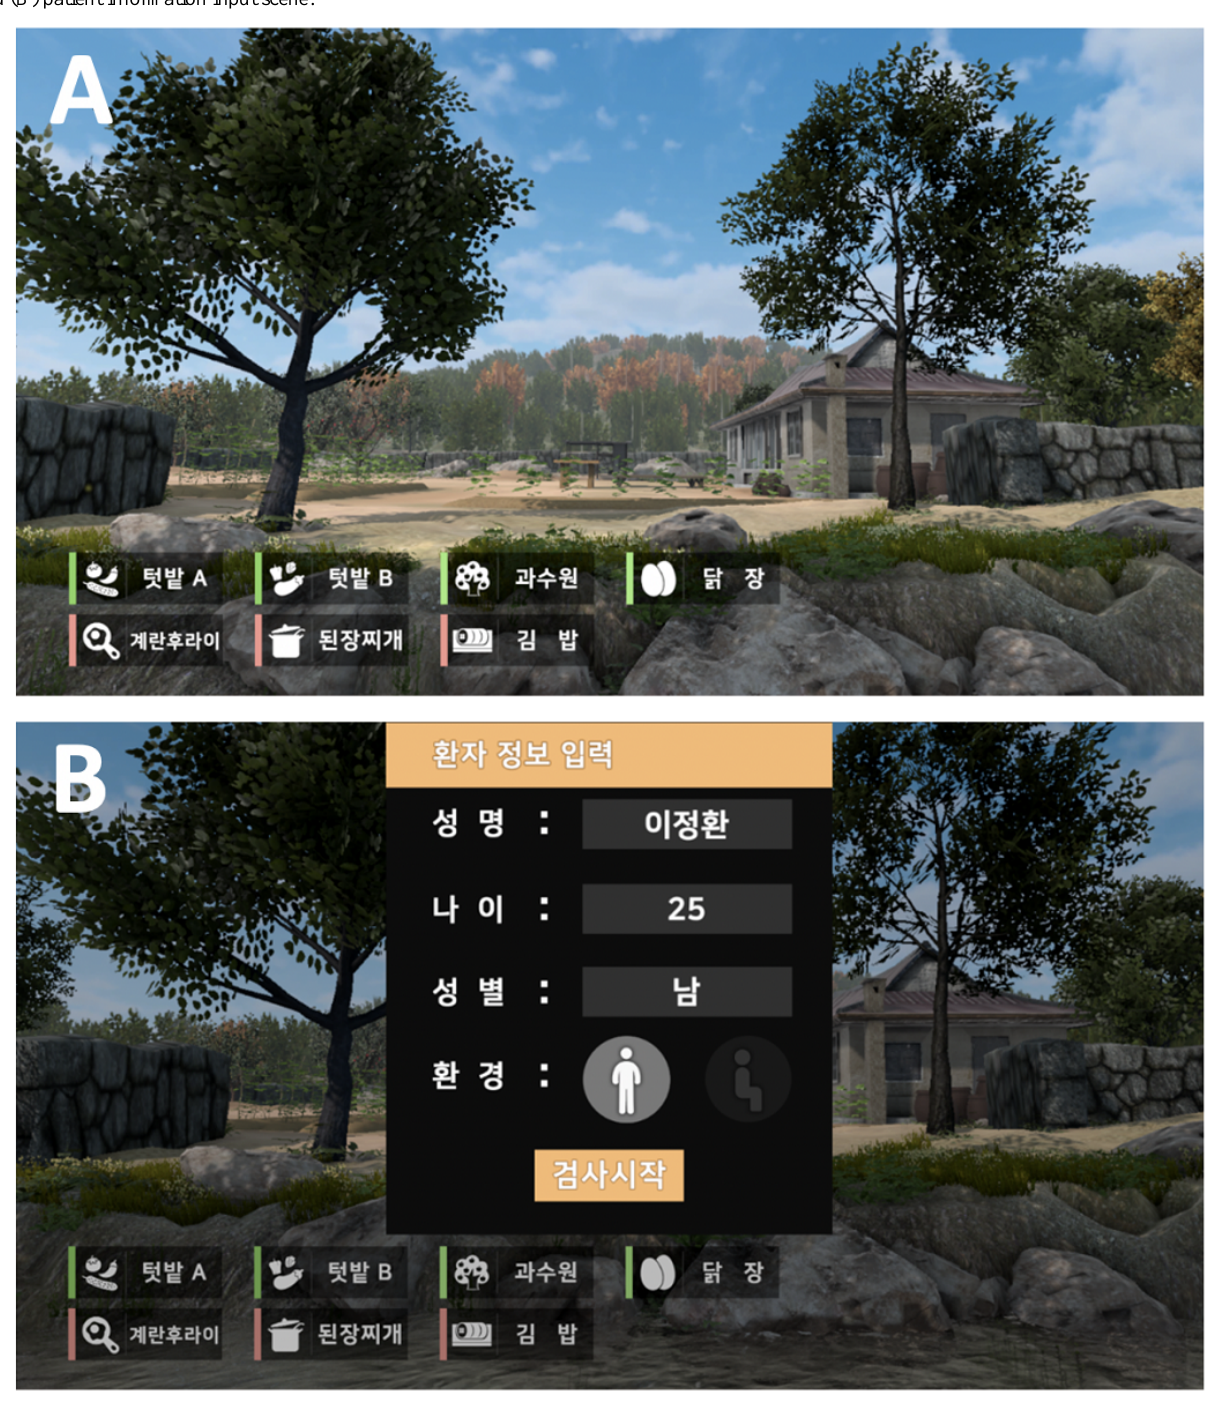
Figure 2. Default scenes in the program: (A) primary scene showing a usual Korean farm village and country house where one could harvest and cook and (B) patient information input